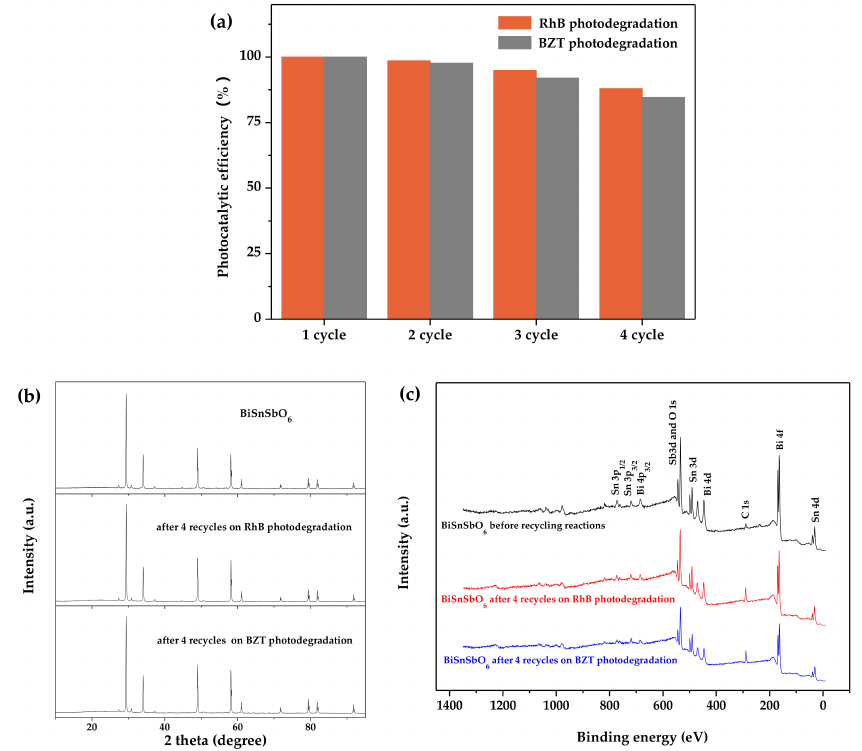
Figure 15. ( a ) The photocatalytic efficiency of RhB degradation or BZT degradation at different recycling time with BiSnSbO 6 as catalyst.; ( b ) XRD spectra of BiSnSbO 6 after four recycles of RhB photodegradation or BZT photodegradation; ( c ) XPS spectra of BiSnSbO 6 after four recycles of RhB photodegradation or BZT